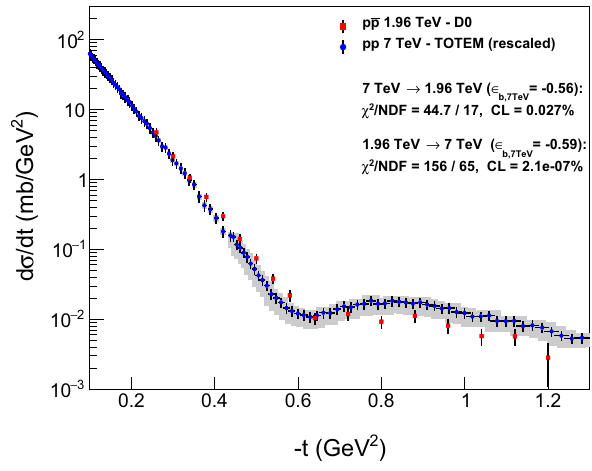
Fig. 16 The artificially reduced Odderon significance, when type C errors are included to the uncertainty of the vertical scale of the differ- ential cross-sections and are added, as a test, quadratically to the type A, point-to-point fluctuating errors, just to estimate the magnitude and the importance of their effect. Due to the large, 14.4% type C errors of the D0 measurement, the vertical scale becomes rather uncertain and the significance of the Odderon signal is reduced substantially. This demonstrates the power of the study of the H ( x ) scaling function: type C errors cancel from H ( x ) and the Odderon signal has a significance of at least 6.26 σ , as compared to the extrapolation of the differential cross-sections, where type C errors do not cancel. If we were allowed to add, incorrectly, the type C and type A errors quadratically, the signifi- cance of the Odderon signal would be reduced to 3.64 σ , corresponding to the χ 2 / N DF = 44 . 7 / 17 shown